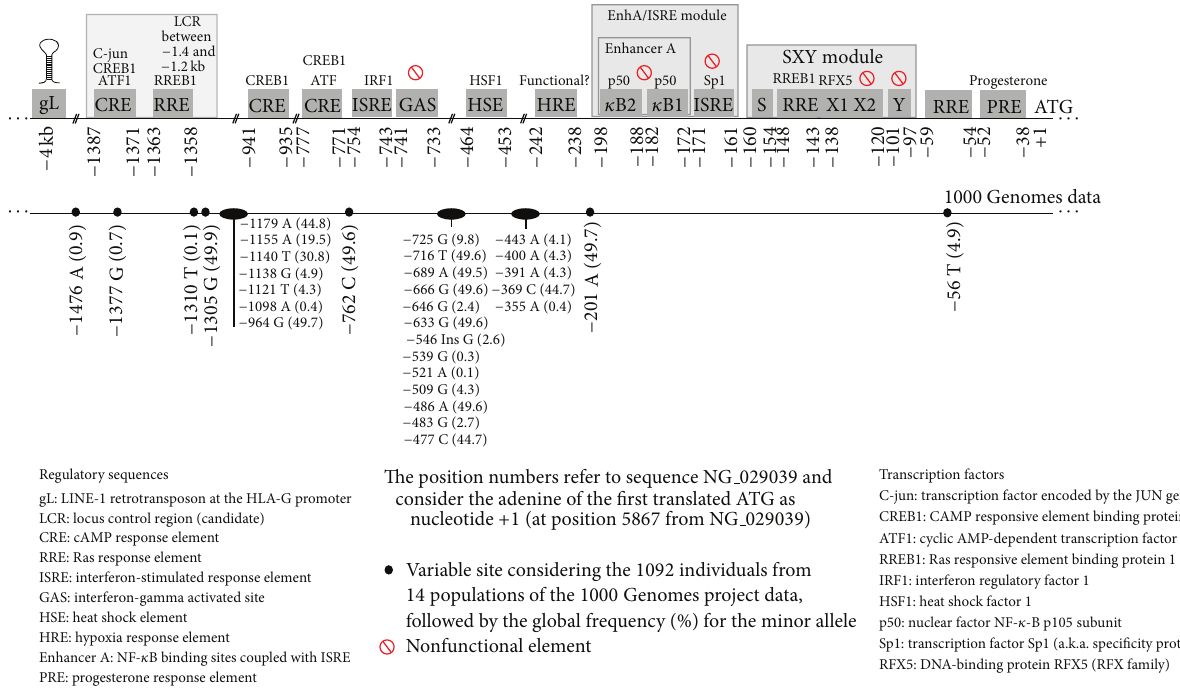
Figure 1: The HLA-G 5 󸀠 regulatory region with its known regulatory elements and variable sites according to the 1000 Genomes data.